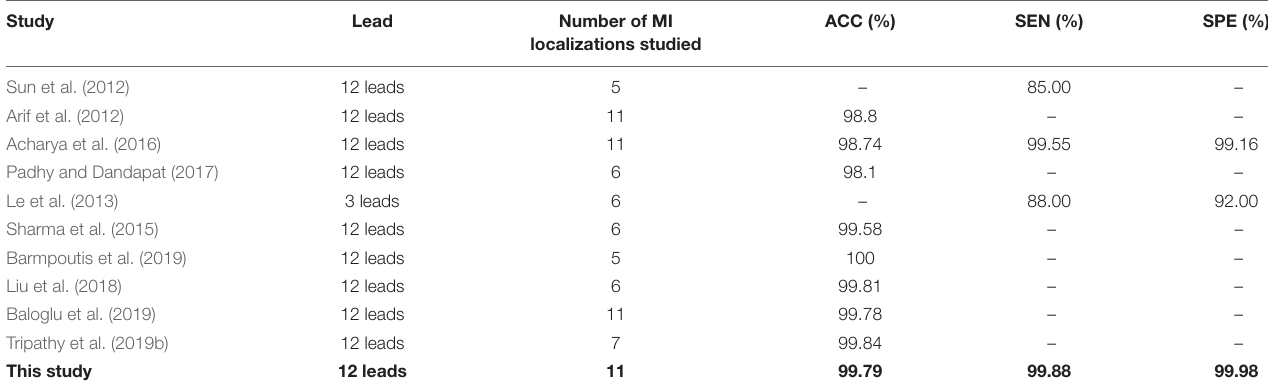
TABLE 7 | Comparison of MI localization results from recent reports with those from this